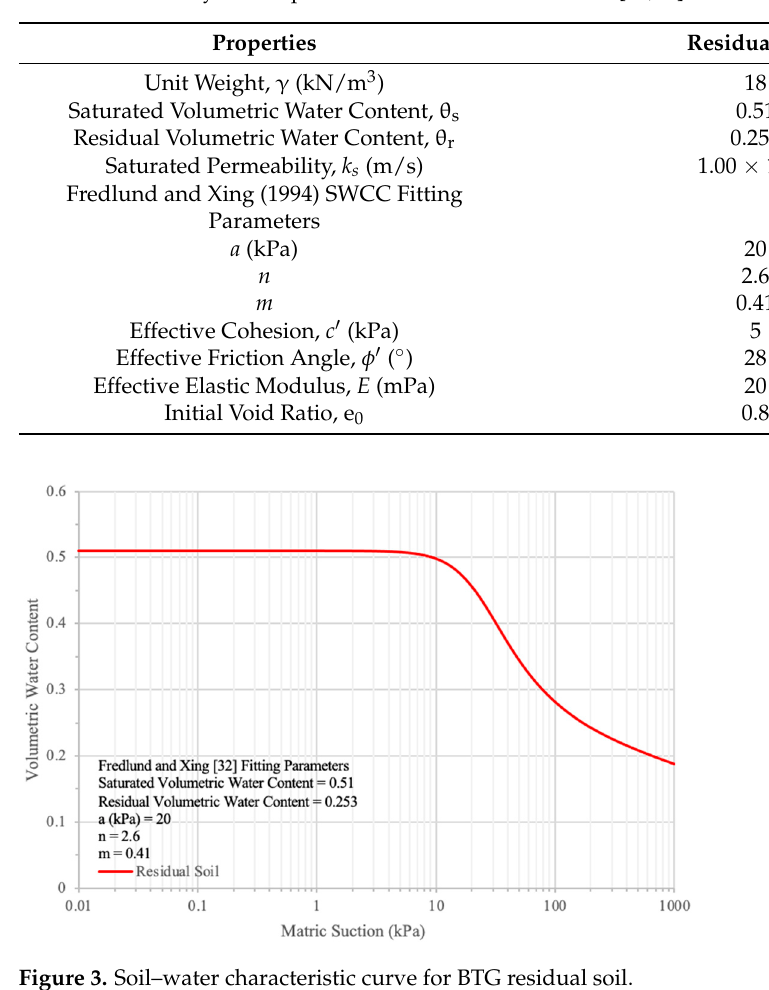
Table 1. Soil and hydraulic parameters for BTG residual soil [14,25].